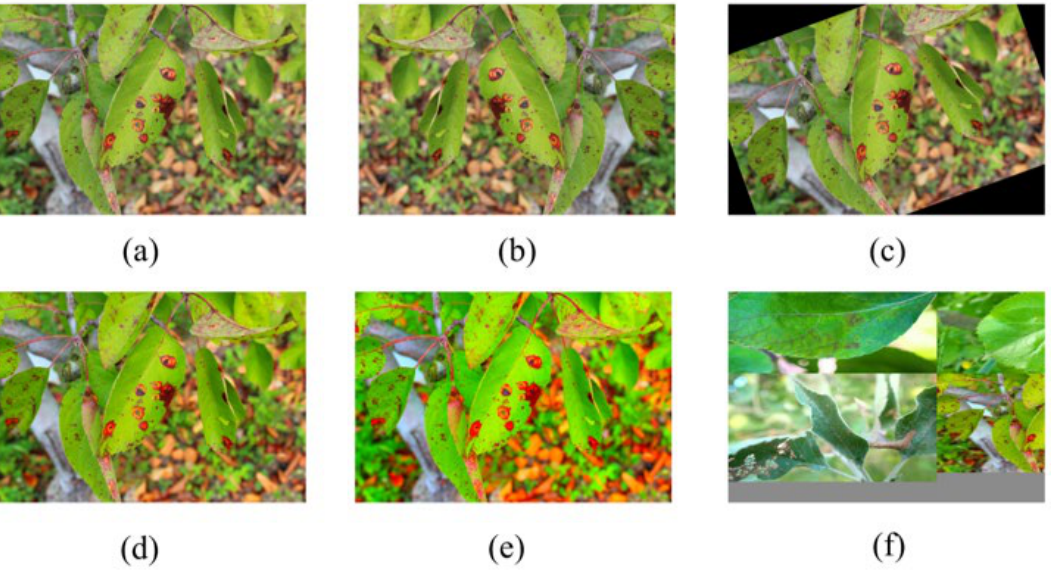
Figure 3. Original and enhanced images. ( a ) Original; ( b ) Flip horizontal; ( c ) Rotation transformation; ( d ) Hue enhancement; ( e ) Saturation enhancement; ( f ) Mosaic enhancement.